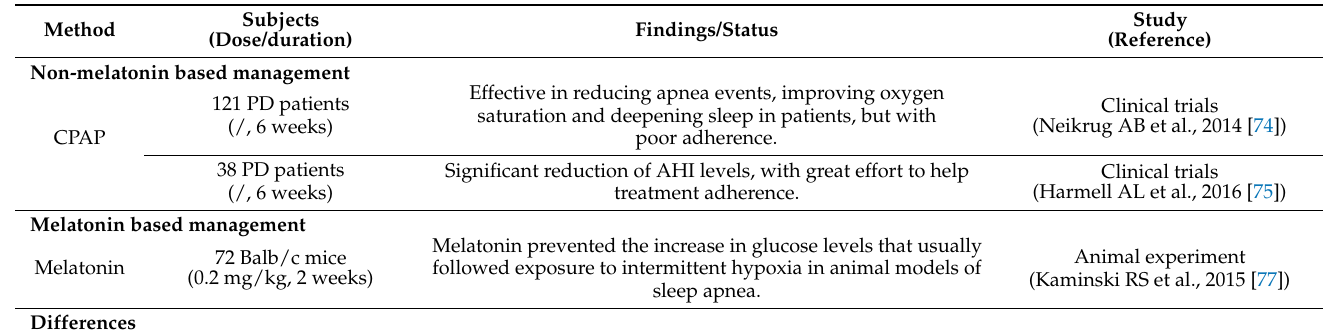
Table 3. SBDs in Parkinson’s disease and their management supported by randomized controlled